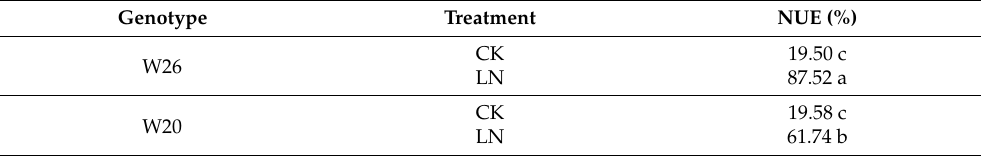
Table 1. Nitrogen use efficiency (NUE) after 21 days of plant